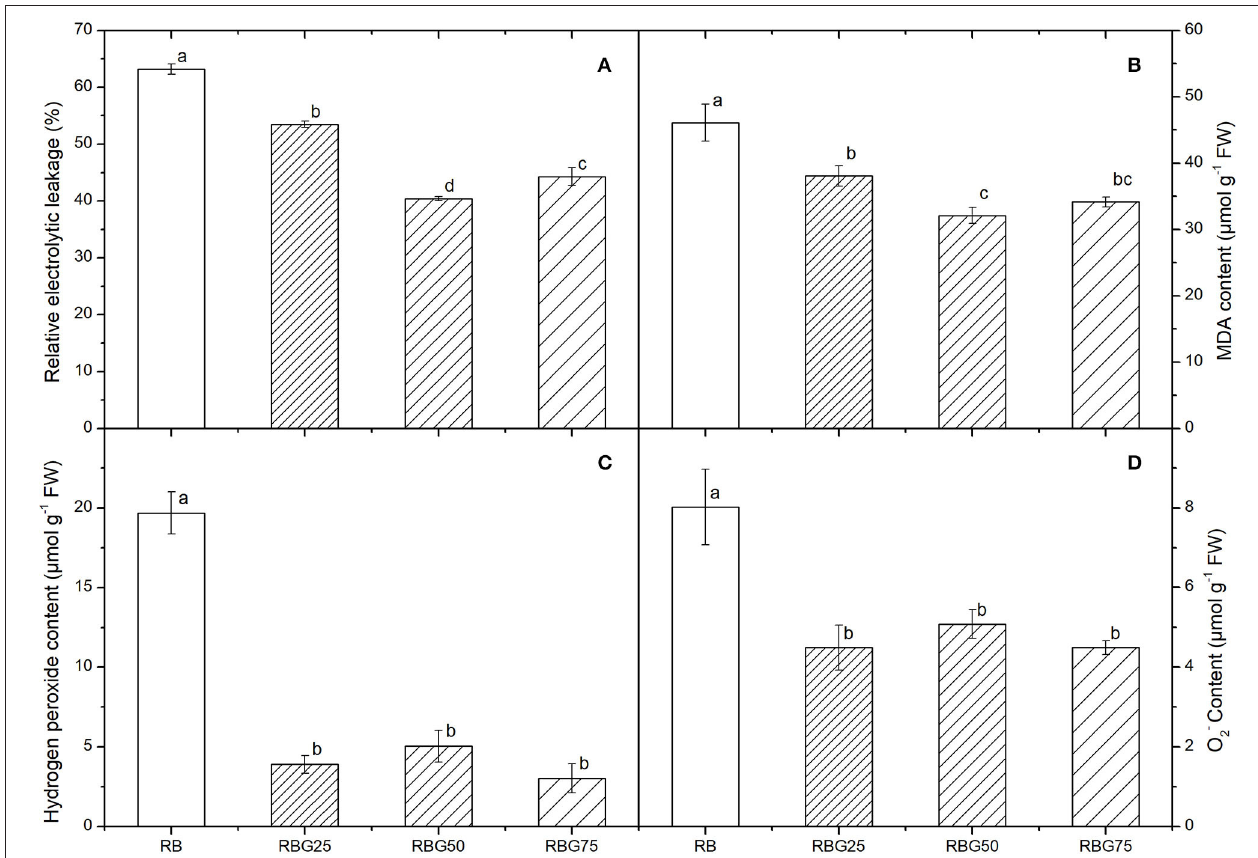
FIGURE 6 | Effect of different spectral conditions on electrolyte leakage, malondialdehyde, hydrogen peroxide and superoxide anion contents of cucumber seeding after 9 days of drought stress. (A) The electrolyte leakage. (B) Malondialdehyde (MDA) contents. (C) Hydrogen peroxide (H2O2) contents. (D) Superoxide anion (O 2 − ) contents. RB, RBG25, RBG50 and RBG75 are the different light spectral conditions, respectively. The PPFD for all the treatments was 250 µ mol m − 2 s − 1 . The data presented were the means ± SE ( n = 3). Different lowercase letters on the bar chart indicated significant differences among treatments according to Tukey’s test ( p <